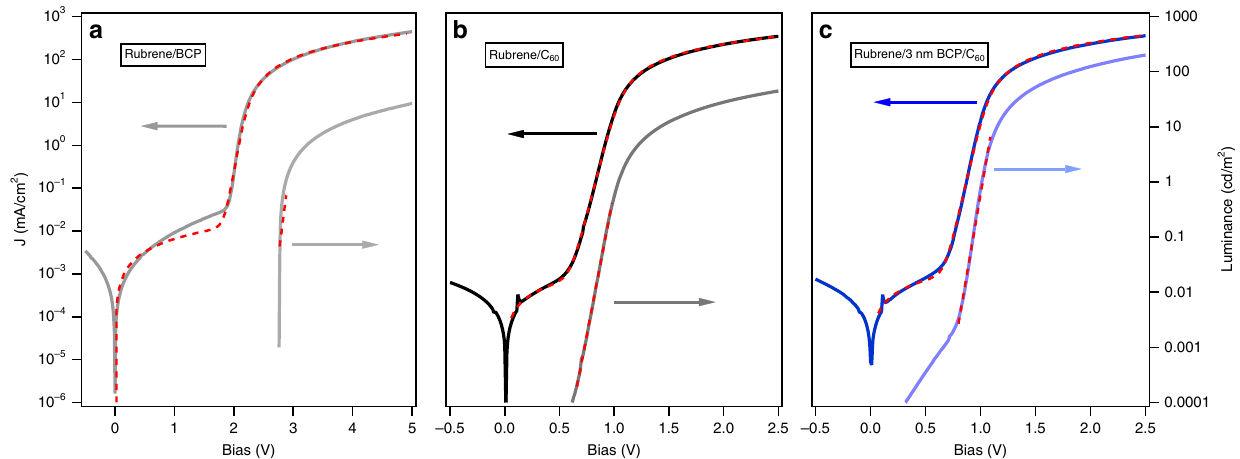
Fig. 6 Equivalent circuit fi t. J ( V )- and L ( J )-characteristics of rubrene/C 60 OLEDs, ( a ) reference device with no C60 ETL, ( b ) baseline device without BCP interlayer, ( c ) optimized device with 3 nm BCP interlayer. Broken red lines correspond to a fi t to a 1-diode-equivalent circuit model and modi fi ed exponential term in case of the J ( V )- and L ( V